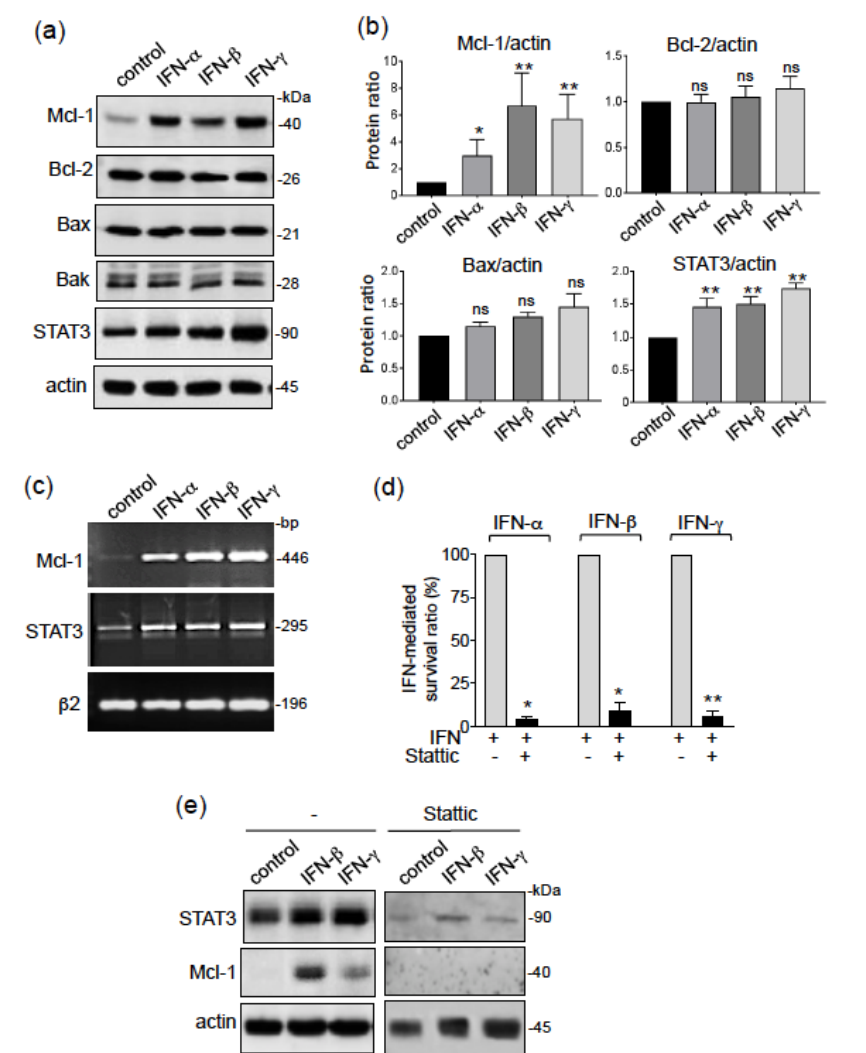
Figure 2. Type I and II IFNs promote CLL cell resistance to apoptosis through an STAT3/Mcl-1 signaling pathway. ( a , b ) Cell lysates from CLL cell samples cultured for 24 h in the presence or absence of IFNs (1000 U/mL), were examined for Mcl-1, Bcl-2, Bax, Bak, STAT3, and actin expression in immunoblot assays (reducing conditions). ( a ) A representative blot is shown; ( b ) Data ( n = 4 for Bcl-2 and Bax; n = 6 for STAT3 and Mcl-1) are expressed as the ratio between the analyte proteins and actin, and presented as mean ± SEM; statistical relevance was assessed with the unpaired t -test. ( c ) RT-PCR analysis of Mcl-1, STAT3 and β 2-microglobulin transcripts after CLL cell treatment for 18 h in the presence or absence of IFNs (1000 U/mL). ( d , e ) CLL cells were cultured for 24 h in the presence or absence of IFNs (1000 U/mL) after a 15 min pretreatment with 5 µ M STAT3 inhibitor: ( d ) IFN-mediated cell survival was determined by subtracting the percentage of annexin-positive cells in the absence of IFN from the percentage of annexin-positive cells in the presence of IFN, and divided by the percentage of annexin-positive cells in the absence of stimulus × 100; the survival of IFN-treated cells in the absence of the inhibitor is considered as a ratio of 100%; the data are presented as mean ± SEM (n = 3). Statistical relevance was assessed with the paired t -test. ( e ) Western blots with antibodies against STAT3, Mcl-1 and actin. * p < 0.05; ** p < 0.01. Whole blots relative to the Western Blotting analyses are presented in Supplemental File Figure